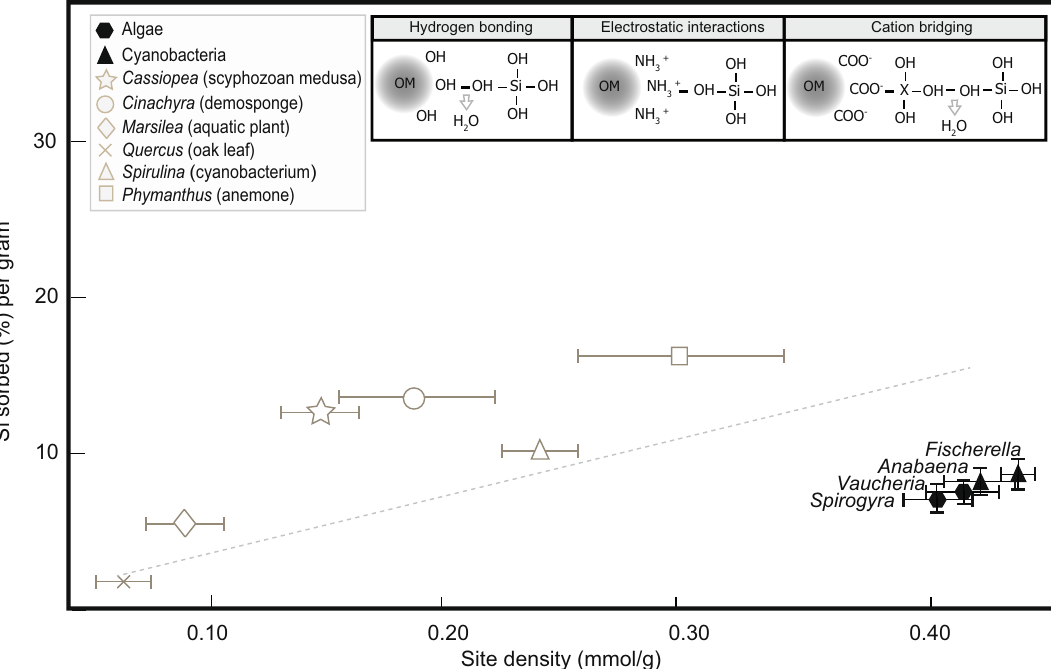
Figure 3. Potentiometric titration results. Mean reactive site density (mmol/g) for experimental organisms, plotted against Si absorbed, measured at the end of each experiment (150 h), and normalized to the average initial weight of each specimen. Error bars represent the standard deviation. Illustrations along the top of the panel represent the molecular bonding of silica to (from left to right) hydroxyl, amino, and carboxyl groups of organic matter (OM) (modified from Ref. 54 ). “X” represents a metal cation. Gray symbols denote data from Ref. 16 . Black symbols represent new data produced for this study. Line denotes best-fit approximation of all these data (y = 83.694x−10.604; R 2 =